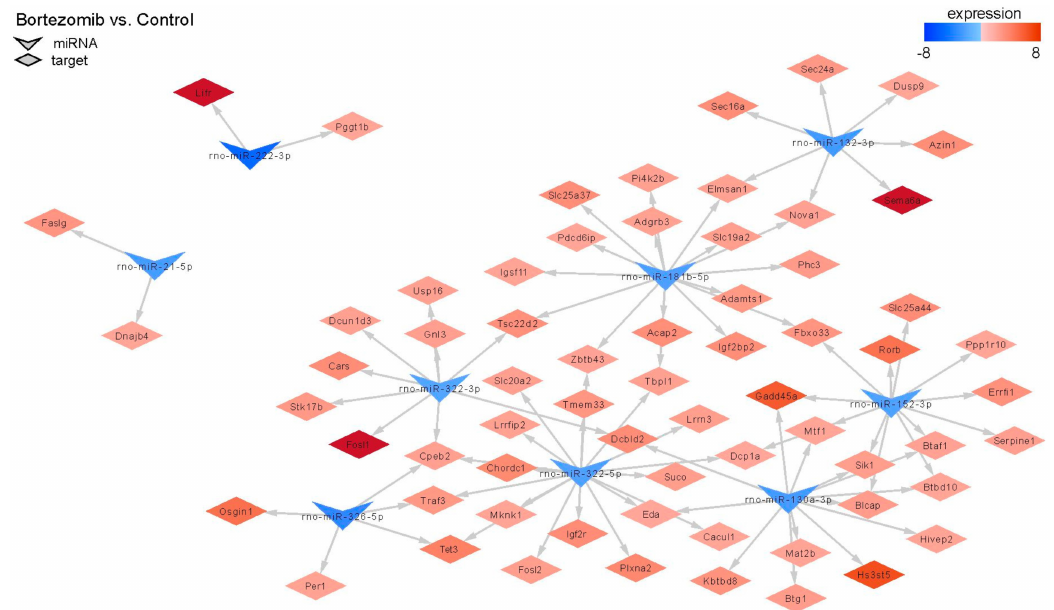
Figure 11. The diagram shows significantly downregulated miRNAs (at least fold − 2). Target genes are assigned to each miRNA with a marked change in expression (at least fold − 2) (red indicates upregulation and blue indicates downregulation).